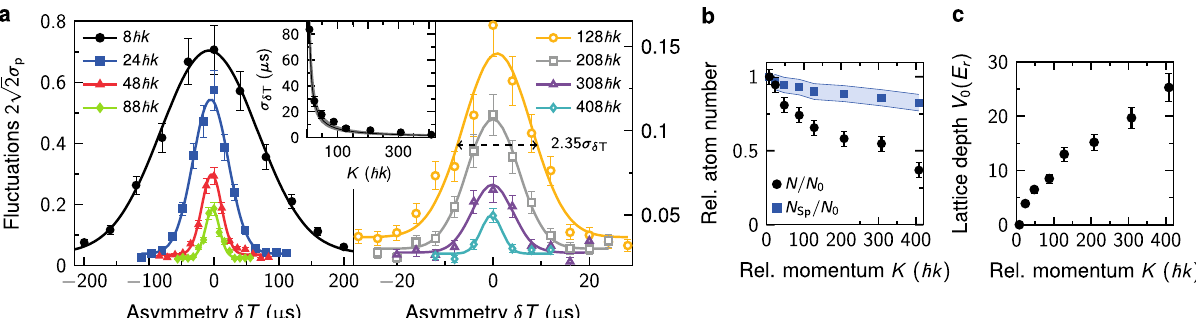
ffiffiffi p σ 2 Fig. 6 Interferometer analysis. a Measured atom number fl uctuations 2 p of the twin-lattice interferometer in dependence of the spatial overlap of the wave packets at the last DBD pulse for increasing relative momenta K and corresponding Gaussian fi ts. The contrast is proportional to the standard deviation σ p of the normalized atom number p at the output port. The error of σ p is given by σ p ð 2 ð n (cid:1) 1 ÞÞ (cid:1) 1 = 2 with n = 40. We modify the spatial overlap by varying the duration of the second free-evolution time by δ T relative to the fi rst one. The displacement of the two wave packets varies with δ TK . Inset: the width σ δ T of the envelopes decays with the inverse of the relative momentum K for a constant spatial coherence length. The line represents the theoretically calculated value σ δ T = ℏ /( K σ v ) for σ v = (0.18 ± 0.03) mm s − 1 . b Relative atom number N / N 0 measured in the output ports normalized to the DBD interferometer ( K = 8 ℏ k ) (black circles) with an absolute error of 0.05. Also, calculated spontaneous emission decay N Sp / N 0 (blue squares) with con fi dence intervals given by the errors in N / N 0 and V 0 . c Lattice depth V 0 applied during acceleration and deceleration with BOs with an assumed relative error of 0.1. Atom number and lattice depth serve as input parameters for our contrast